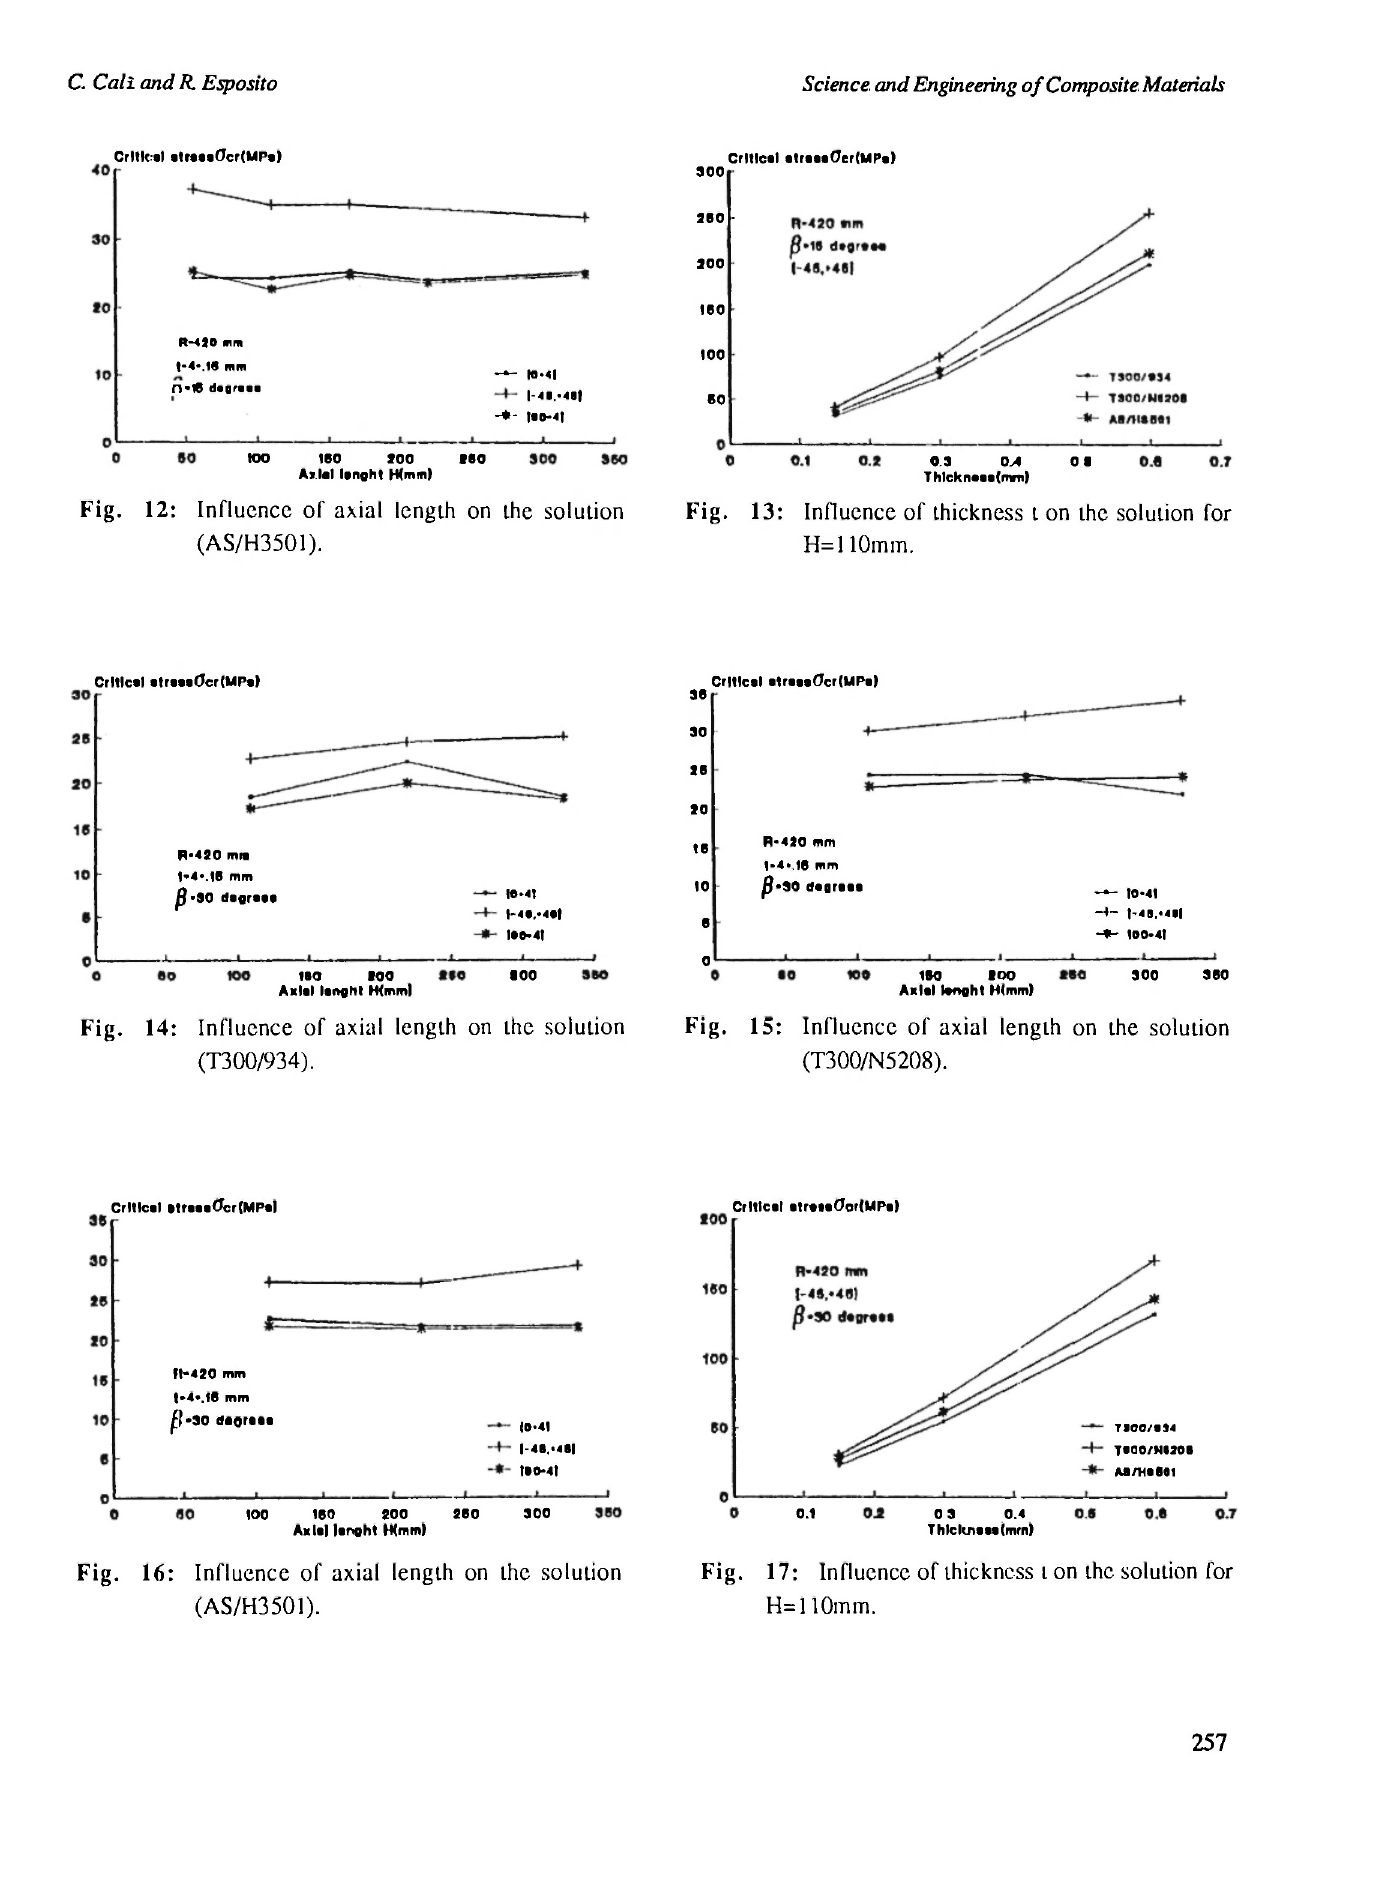
17: Influence of thickness ι on the solution for